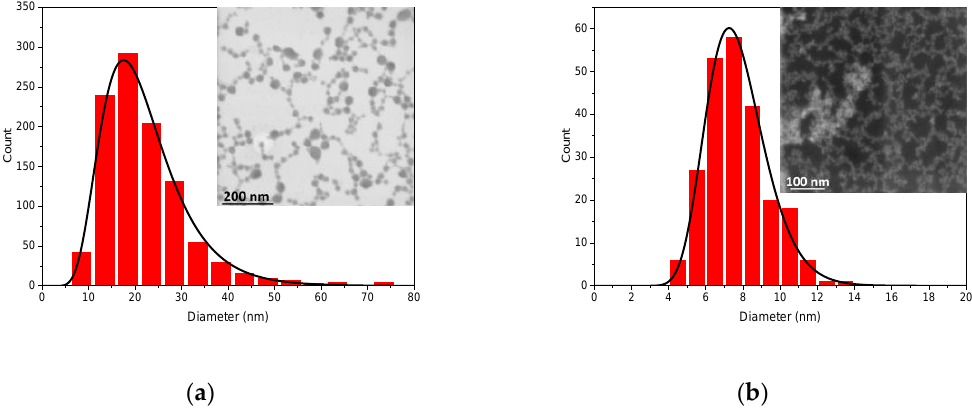
Figure 6. Size distributions with typical scanning transmission electron microscopy (STEM) images of Sm oxide NPs after fs LFL at: ( a ) 50 µJ and ( b ) 100 µJ pulse energies.